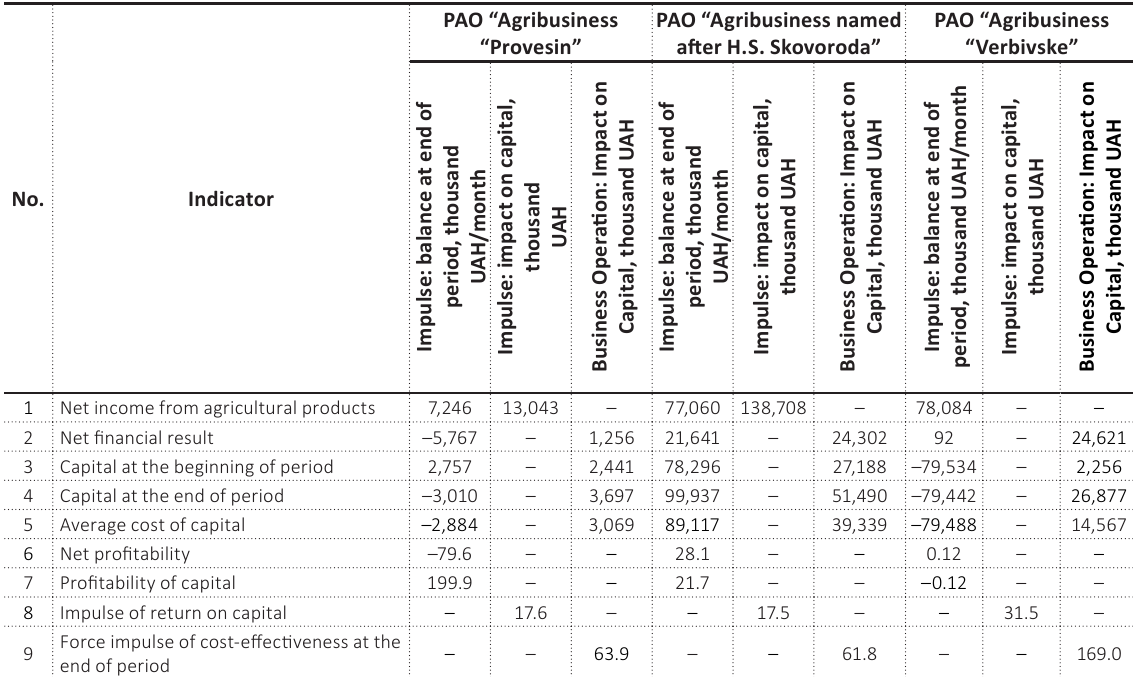
Table 3. Estimation of capital cost-of-living impulses in the context of the net margin method